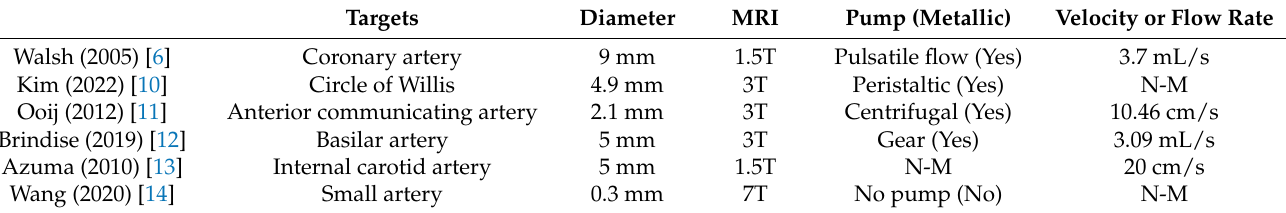
Table 1. Specifications of circulation systems used for vascular phantom studies. Targets Diameter MRI Pump (Metallic) Velocity or Flow Rate Coronary